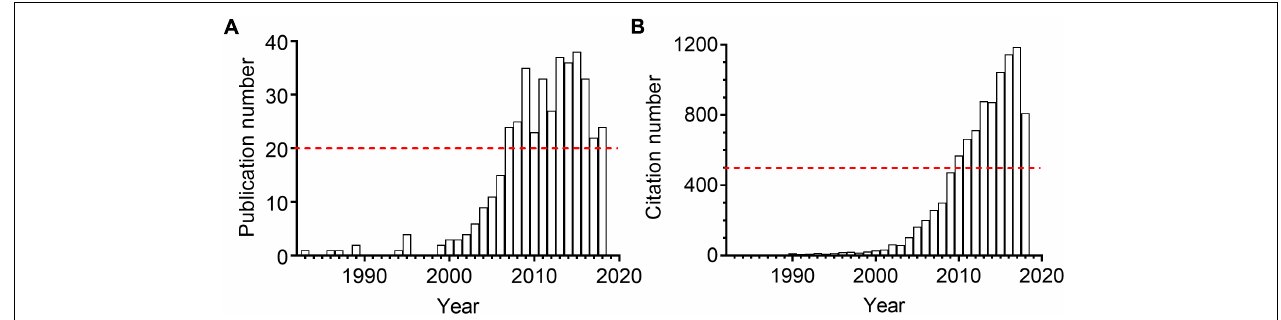
FIGURE 2 | The annual publication numbers (A) and the resulting citation numbers (B) of the scientific paper regarding sEH and kidney. The results were generated by searching the Web of Science with the topic “sEH” combined the topic “kidney or renal” on October 1, 2018.